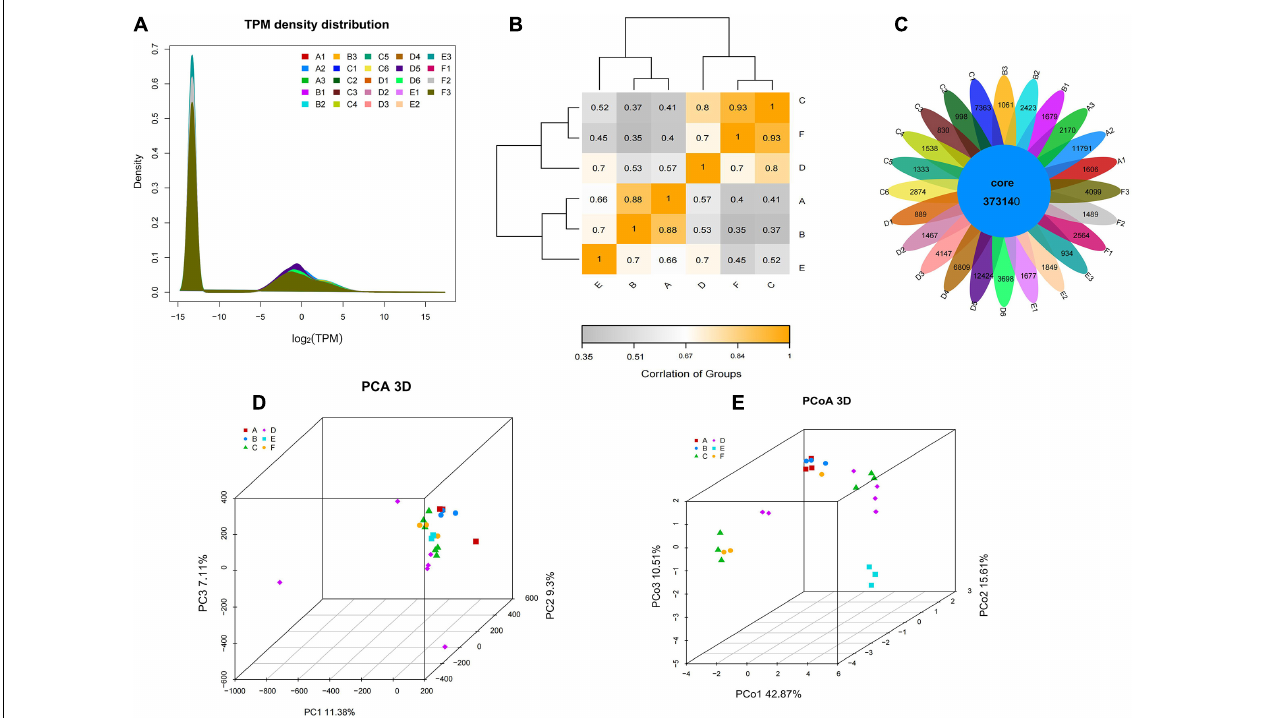
FIGURE 4 | The gene expression level and the intergroup correlation analysis. (A) The TPM density distribution between groups. (B) Heatmap cluster analysis of the correlation among samples. (C) The Venn of coexpression and specific genes. (D) PCA visualization of the different groups. (E) PCoA visualization of the different